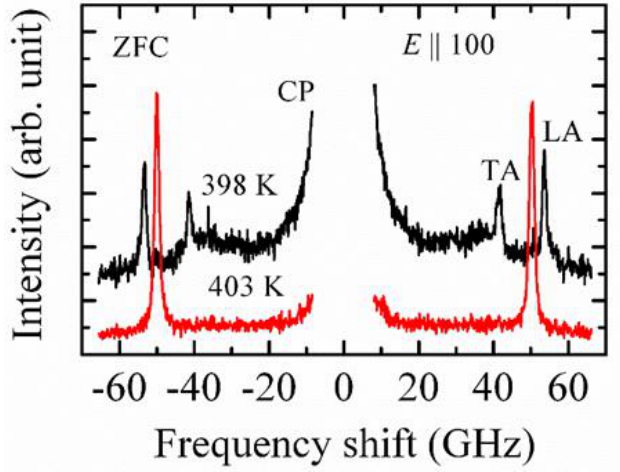
Figure 3. Brillouin scattering spectra at 398 and 403 K of (100)-oriented BaTiO 3 single crystals.